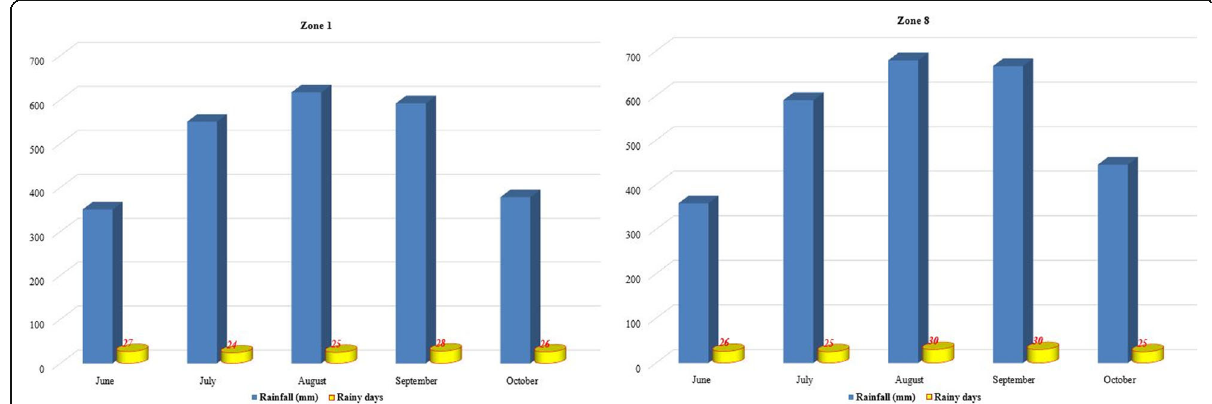
Fig. 5 Monthly rainfall and rainy days sampled for two zones of the study area in 2019 (Source – Local agro-meteorology offices